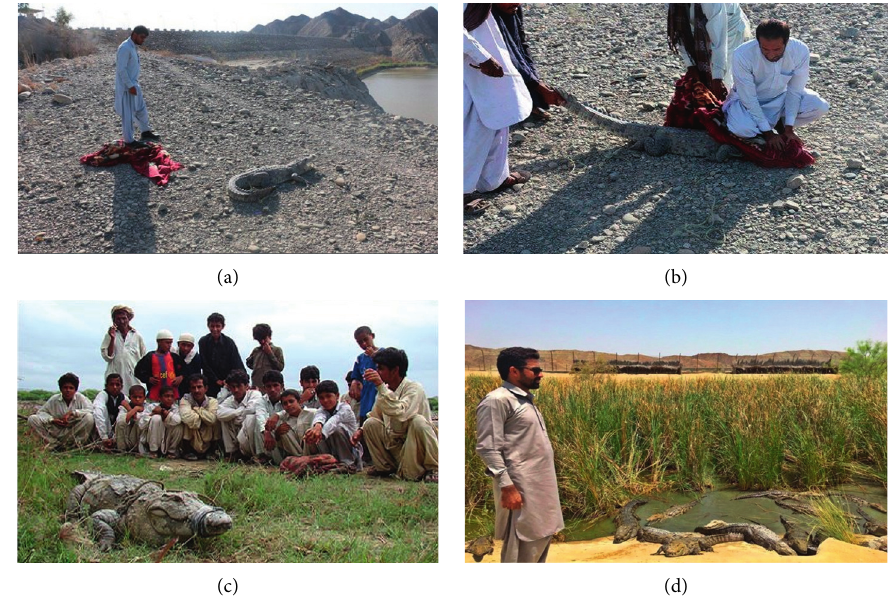
Figure 12: Crocodiles during flooding in the study area